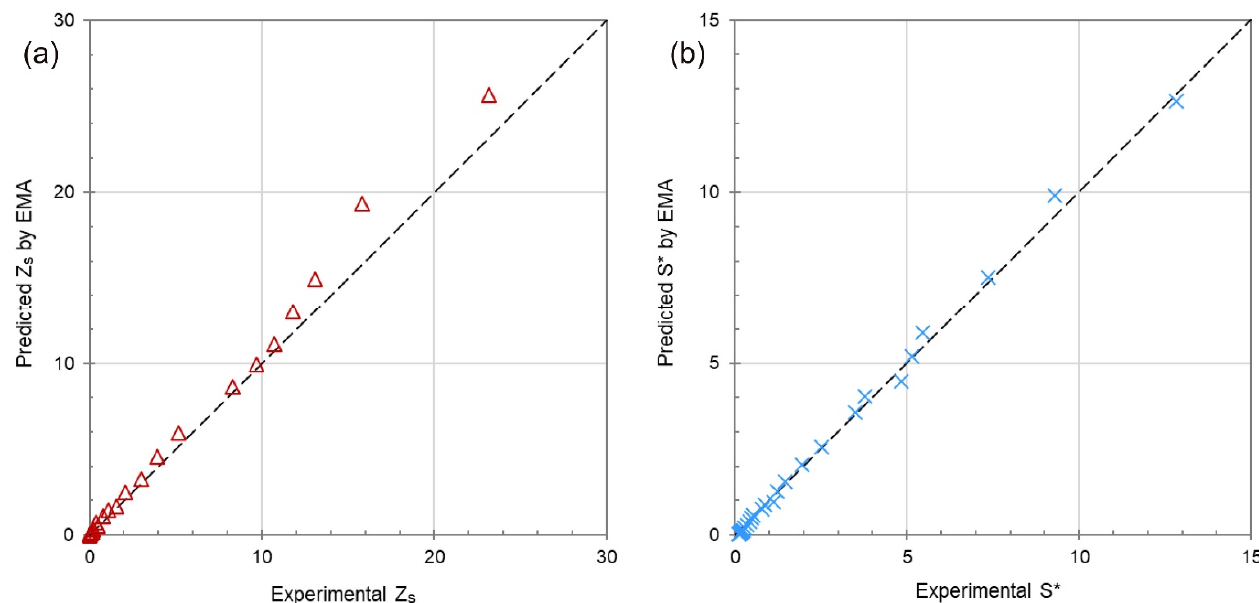
of the spreading layer; and 0 . 0